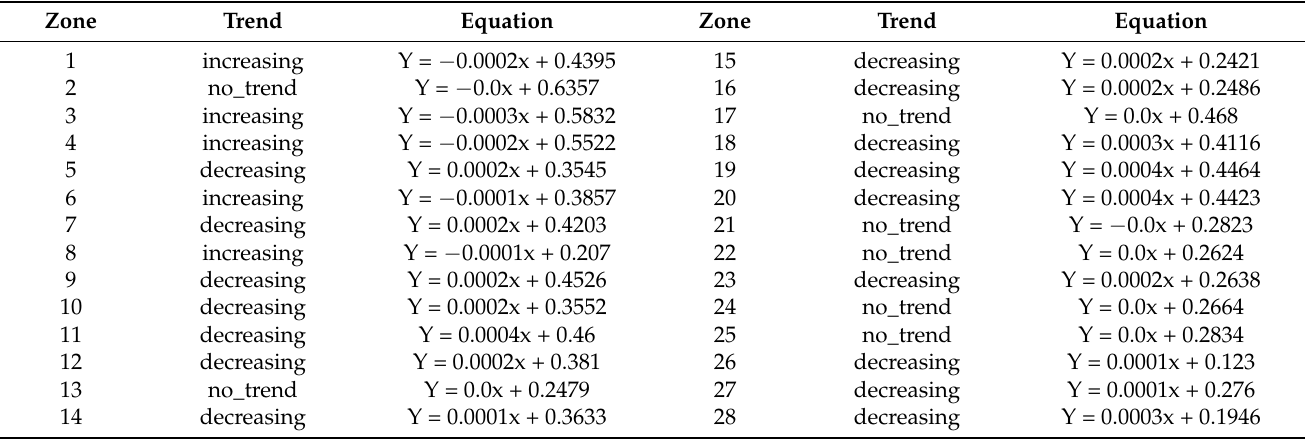
Figure 9. Trend of drought for Zone 1 and Zone 23 in the MKB. Table 3. Drought trend and equation slopes of 28 zones within the